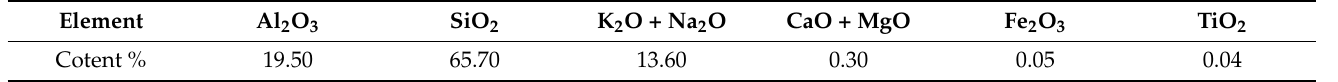
Table 1. Multielement chemical analysis results of feldspar